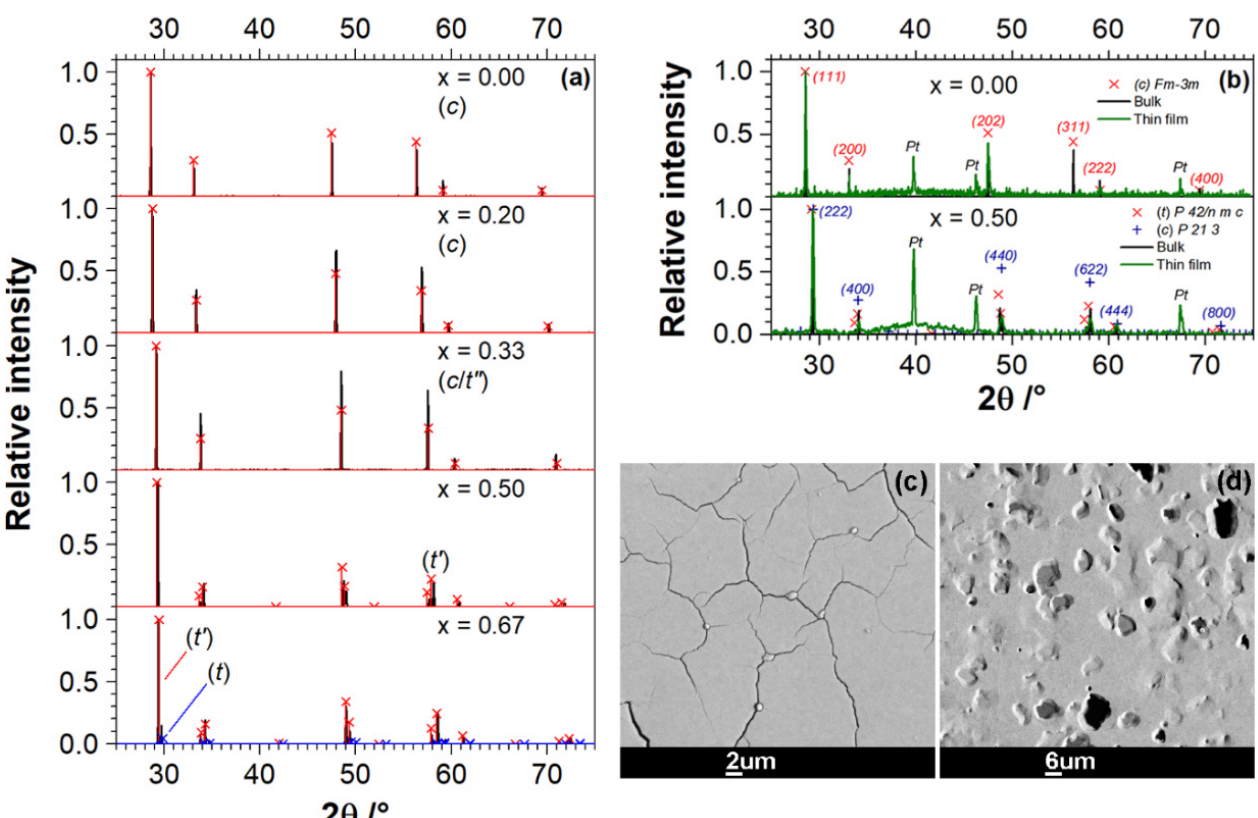
Figure 3. X-ray diffractograms of sintered bulk Ce 1 − x Zr x O 2 targets ( a ), CZO-0, and CZO-50 thin films ( b ) and the back- scattered electron (BSE)-mode SEM images of CZO-0 ( c ) and CZO-67 ( d ) thin films deposited and annealed on single crystal sapphire substrate for electrical conductivity measurements. In ( a , b ), the red crosses mark the cubic c ( Fm-3m ) or tetragonal t’ phases for Ce-rich and Zr-rich samples, respectively. In ( a ), the blue crosses mark the stable tetragonal t phase in bulk Ce 0.33 Zr 0.67 O 2 . In ( b ), the blue pluses indicate the positions for reflections of metastable primitive cubic P 21 3 phase [82,83].